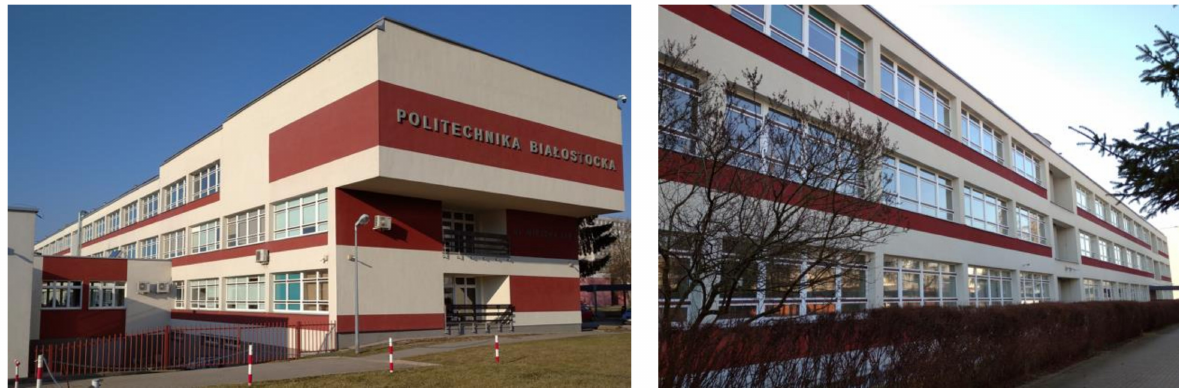
Figure 10. The view of building A after thermomodernization with visible reconstruction, character- istic for the red stripes along the building, under the windows [photo